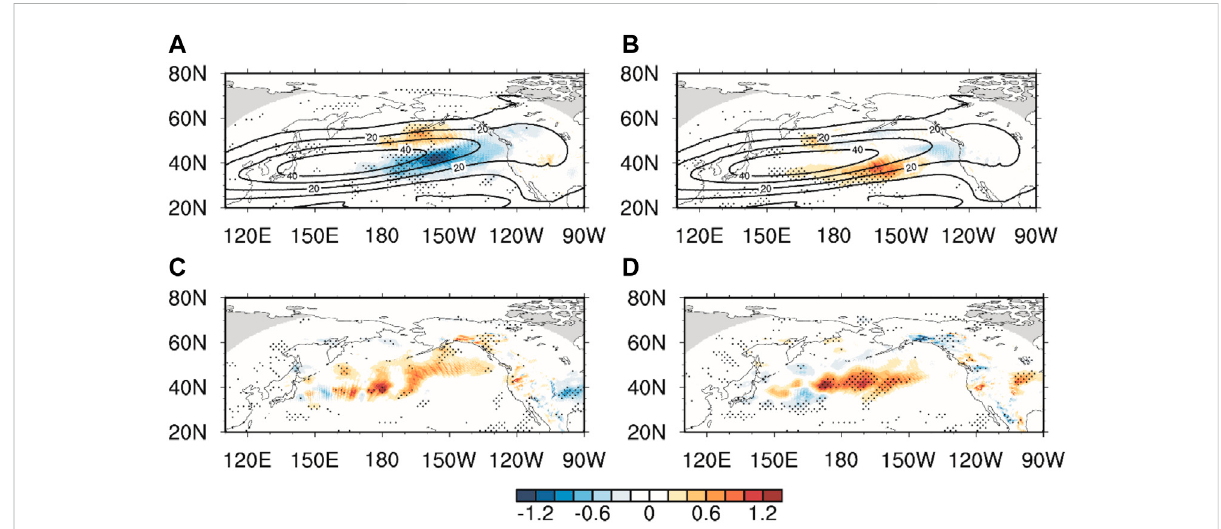
FIGURE 9 Response of energy conversion terms to (A,B) KE-related mesoscale SSTAs (KSTS-MEFS) and (C,D) KE-related large-scale SSTAs (MEFS-CTRL) at 850 hPa. (A,C) Energy conversion from mean available potential energy to eddy available potential energy (BCEC1, W m − 2 , shading). (B,D) Energy conversionfromeddyavailablepotentialenergytoeddykineticenergy(BCEC2,W m − 2 ,shading).Statisticallysigni fi cantdifferencesat90%according to Student ’ s t test are